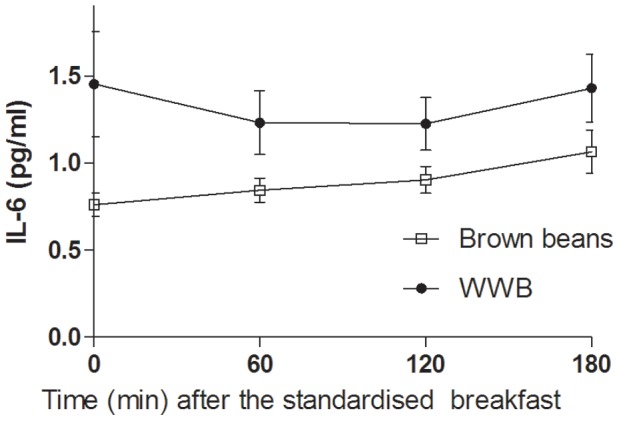
Concentrations of serum IL-6 fasting and after a standardized breakfast, consumed 11 hours after evening meals composed of brown beans or WWB.A significant treatment effect (type of evening meal) was found over the test period (p<0.05, PROC MIXED in SAS release 9.2; SAS Institute Inc, Cary, NC). n = 16 subjects.